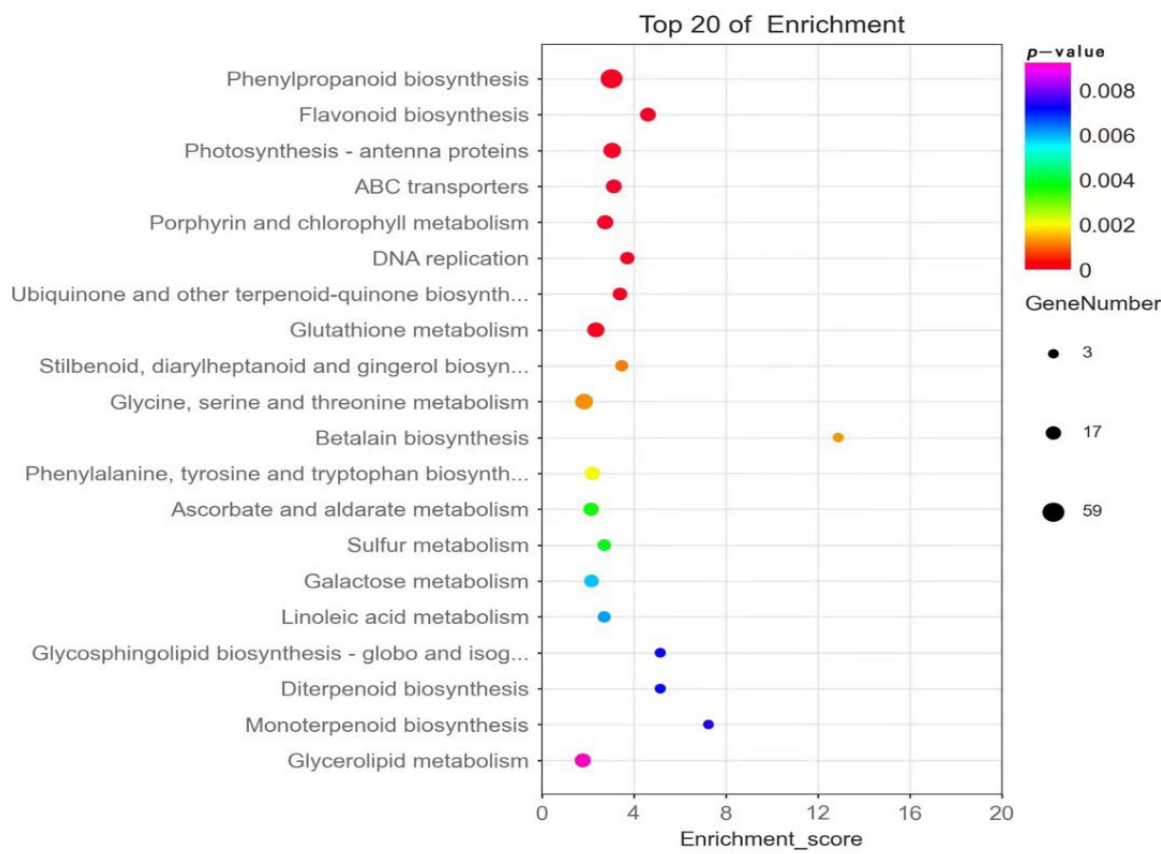
Figure 8. KEGG pathway enrichment analysis of DEGs between CK and P. CK, no Pga inoculation; P, Pga inoculation. The X–axis represents the enrichment score. The size of the bubble indicates the number of DEGs enriched in the pathway, and the color of the bubble indicates the magnitude of the p –value. The smaller the p –value, the greater the significance.